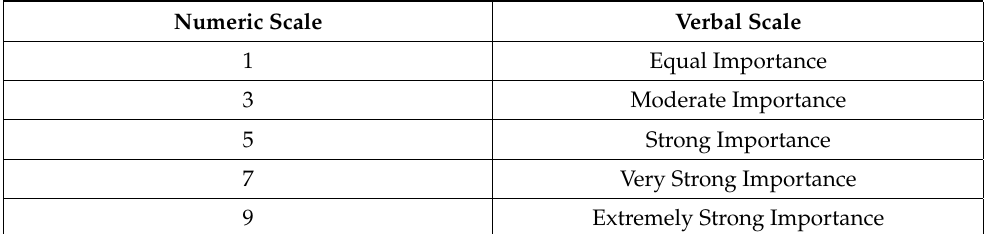
Table 1. Saaty’s Verbal Scale and Numeric